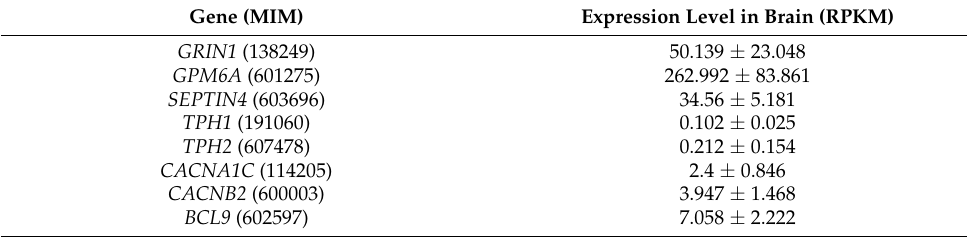
Figure 1. Venn diagram depicting the overlap of genes across schizophrenia and depression; pink color—schizophrenia genes; green color—depression genes; brown color—genes of schizophrenia and depression comorbidity. Table 2. Genes responsible for schizophrenia and depressive disorder comorbidity and their expres- sion in the human brain (adapted by the authors from